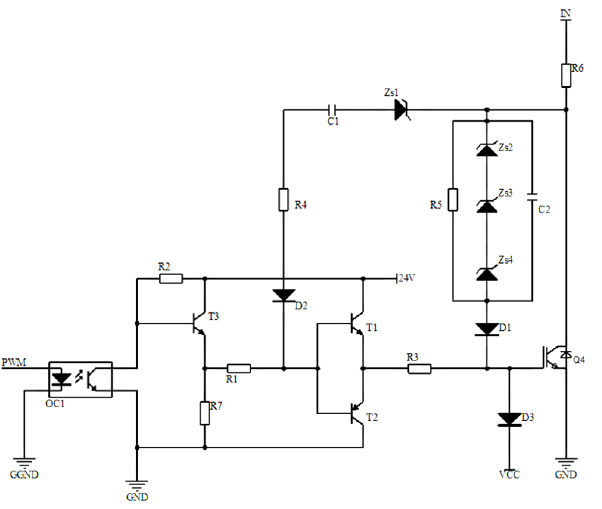
Figure 3. Overvoltage suppression